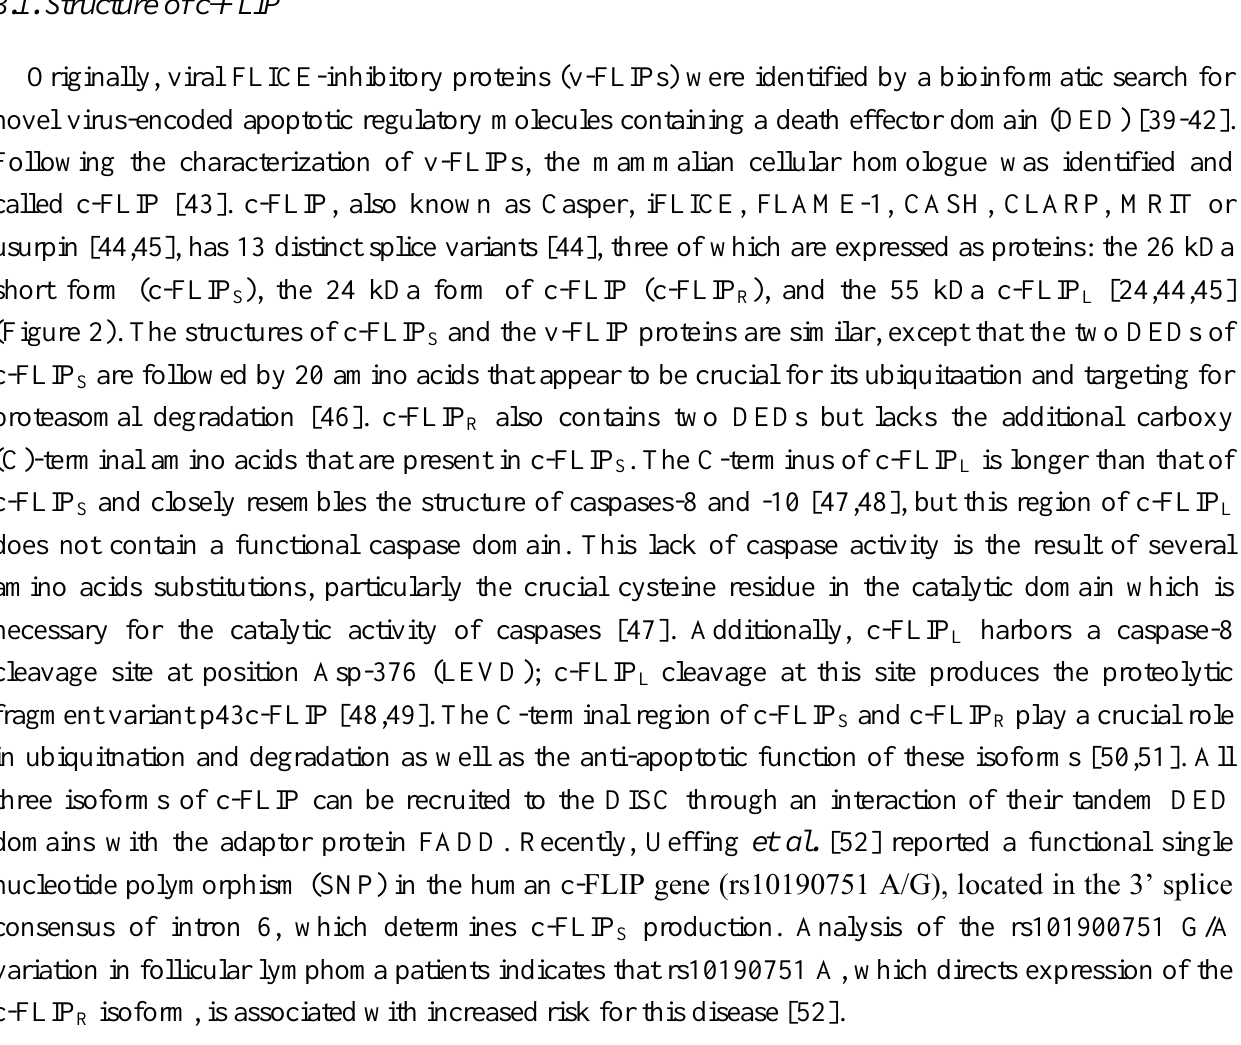
Figure 2. Structures of c-FLIP isoforms. Three c-FLIP isoforms, c-FLIP